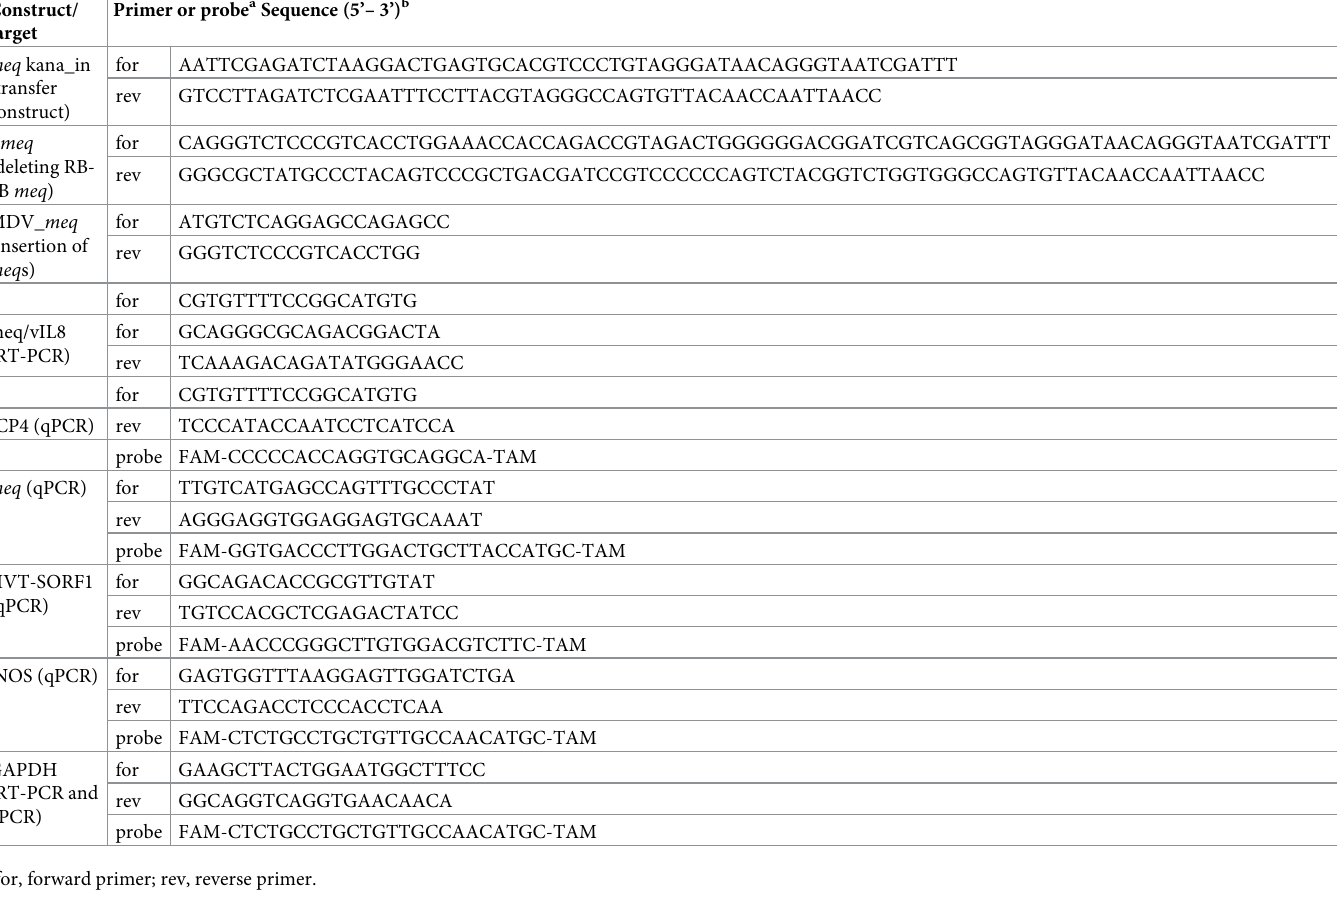
Table 1. Primers and probes used for construction of recombinant viruses, DNA sequencing and qPCR. Construct/